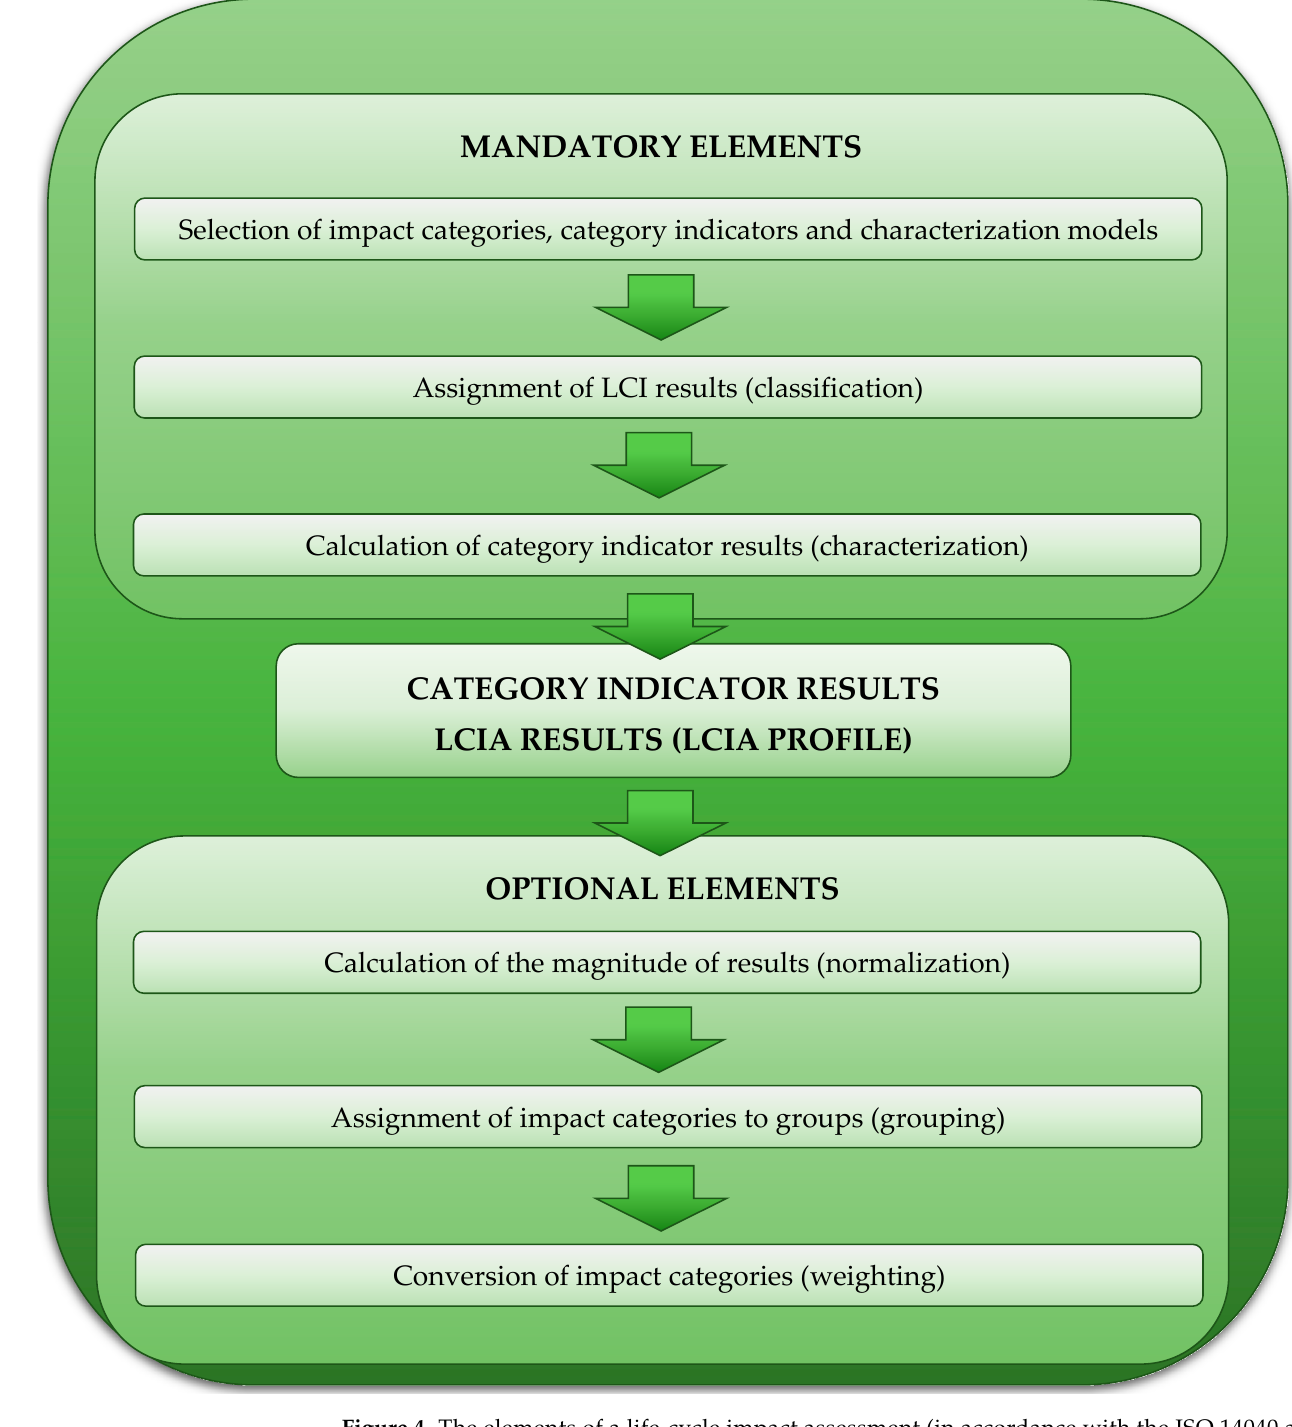
Figure 4. The elements of a life-cycle impact assessment (in accordance with the ISO 14040 and 14044 standards).